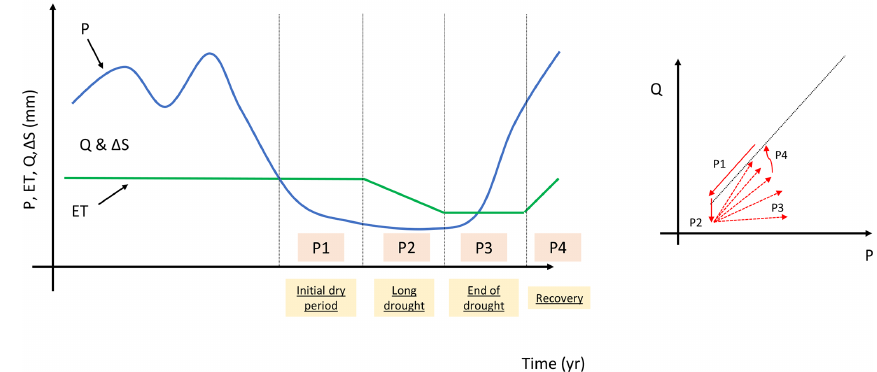
Figure 11. Schematic of ET response to climate variability and its effect of the precipitation–runoff relationship. ET is initially approximated constant with time due to its significantly smaller variability than precipitation (Bales et al., 2018; Orth and Destouni, 2018). Details on the four phases of precipitation–runoff hysteresis ( P 1 to P 4 ) are discussed in Sect.